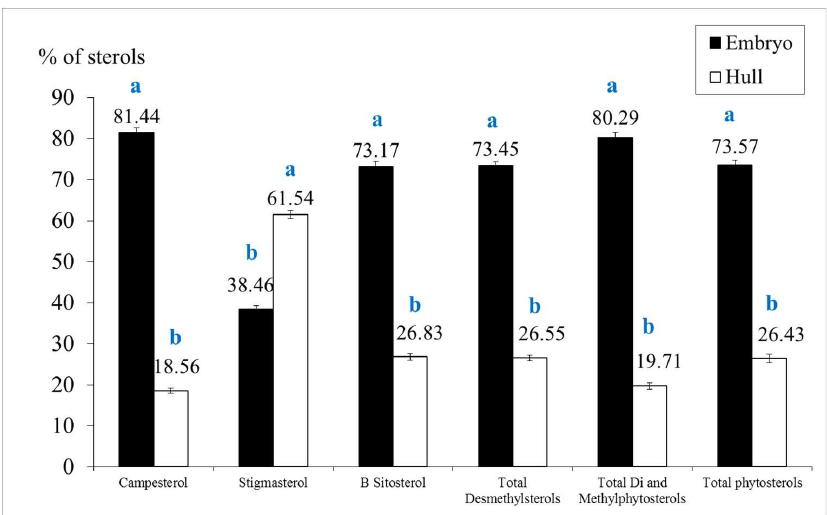
Figure 2. Distribution of phytosterols between the embryo and hull of safflower seeds cultivated under conventional conditions (for each sterol of group means with the same letter are not significantly di ff